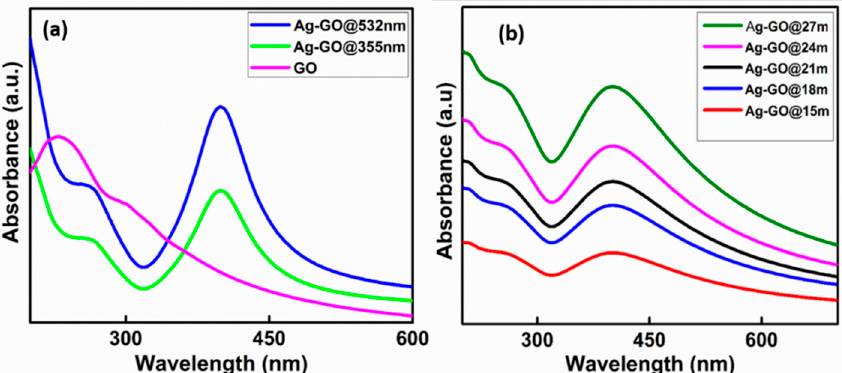
ples at 355 nm and 532 nm laser wavelengths and ( b ) Ag-GO nanohybrids synthesized at different ablation times (15, 18, 21, 24, and 27 min).